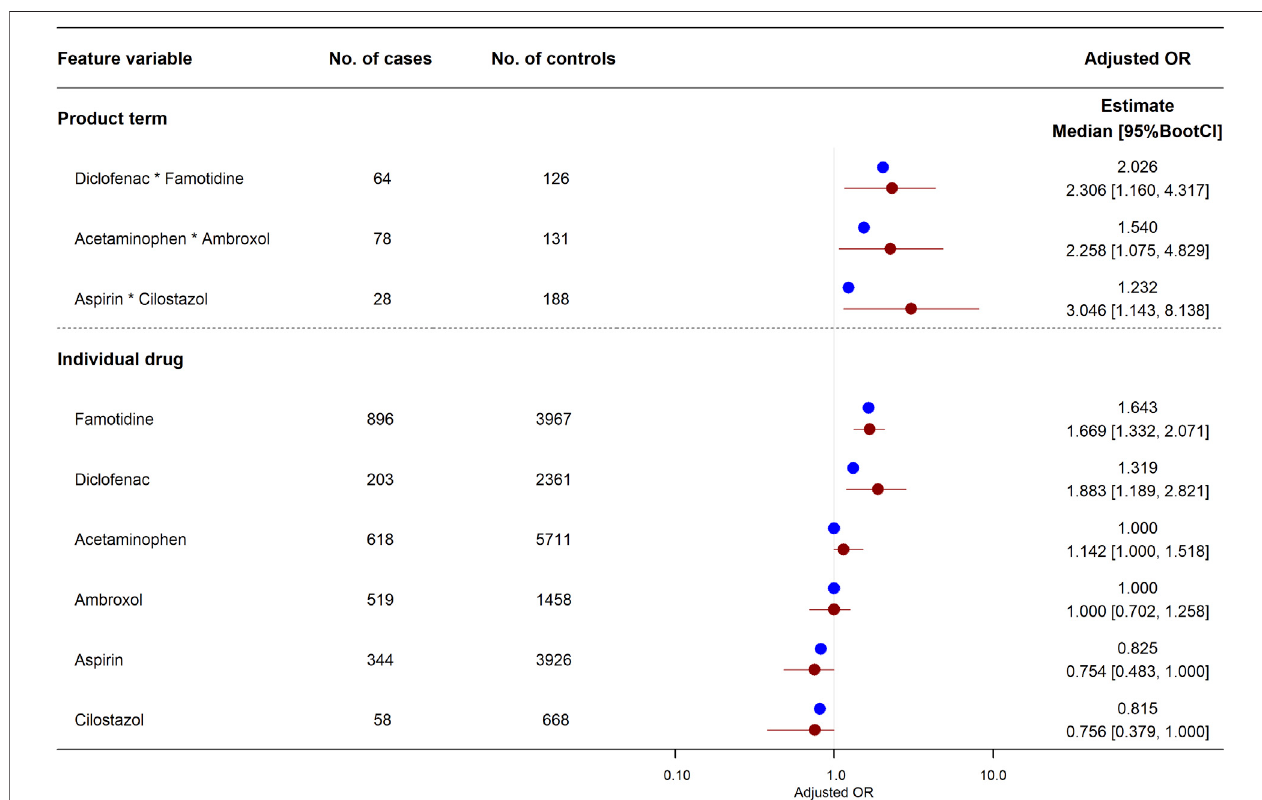
FIGURE 2 | Effects of individual drugs and their product terms on risk of abnormal elevation of ALT in logistic least absolute shrinkage and selection operator (LASSO) regression model. Three product terms had a lower limit of adjusted odds ratio 95%BootCI > 1. Blue and red circles represent estimated adjusted odds ratio in original training set and median of adjusted odds ratio in 2,000 bootstrap replicates, respectively. Red horizon indicates adjusted odds ratio 95%BootCI. 95%BootCI, 95% bootstrap percentile con fi dence interval; OR, odds